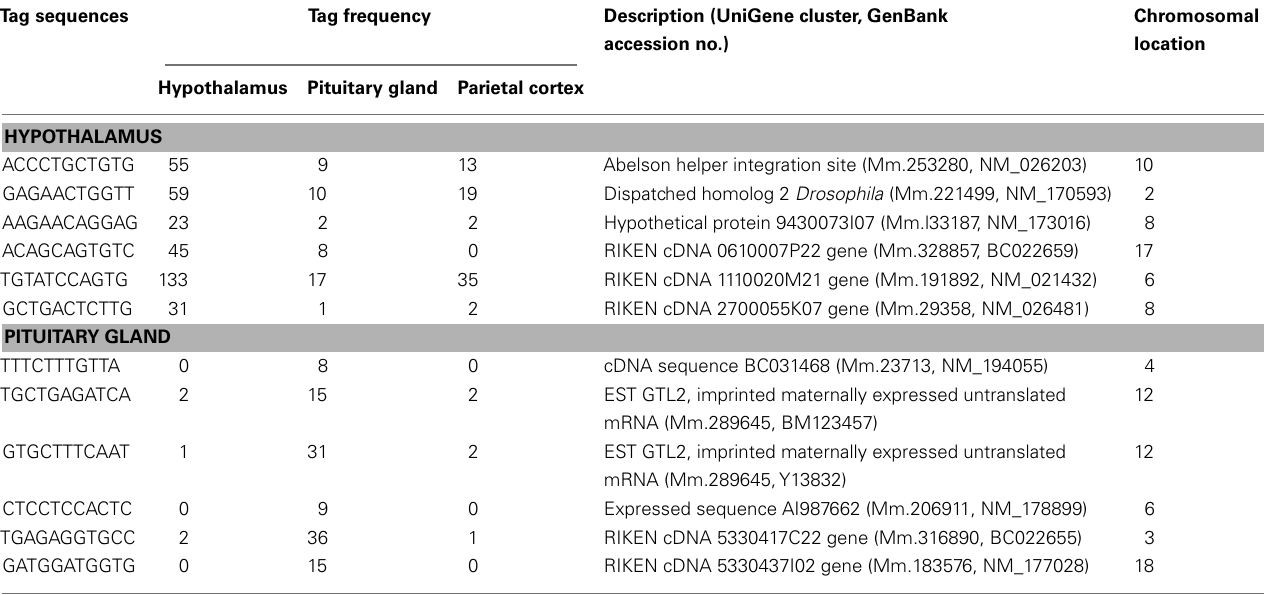
Table 7 | Unclassified transcripts preferentially expressed in the hypothalamus and pituitary gland. Tag